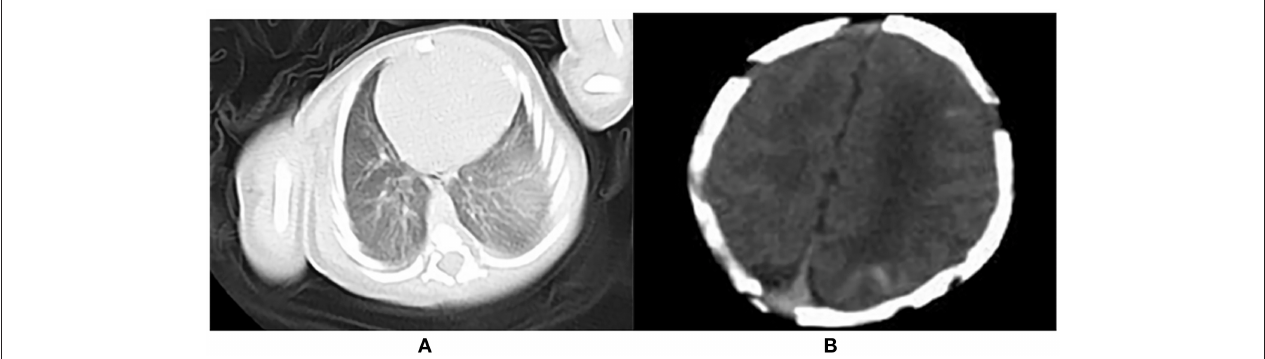
FIGURE 3 | (A) Lack of air in the lung; (B) Multiple hemorrhagic lesions in the left frontal, temporal and parietal